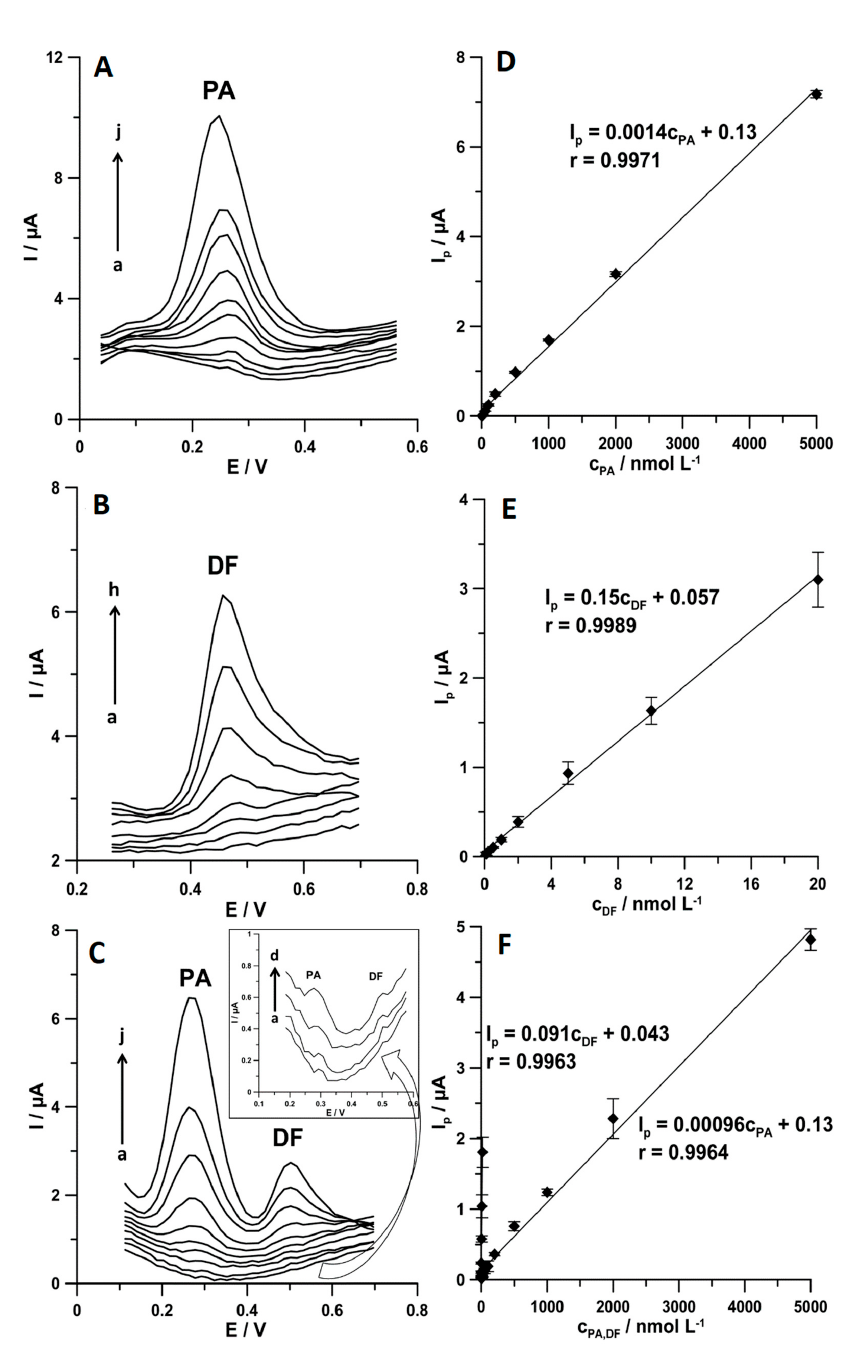
Figure 9. DPAdSV curves registered at the SPCE/MWCNTs-COOH in 0.15 mol L − 1 the acetate buffer solution of pH 4.0 ± 0.1 containing increasing concentrations of the following: ( A ) PA (a–j, 5.0–5000.0 nmol L − 1 ), ( B ) DF (a–h, 0.1–20.0 nmol L − 1 ), and ( C ) PA (a–j, 5.0–5000.0 nmol L − 1 and DF (a–h, 0.1–20.0 nmol L − 1 ). Calibration graph of ( D ) PA, ( E ) DF, and ( F ) PA and DF. The DPAdSV parameters are as follows: E acc. of 0.1 for 1 s and − 0.25 V for 1 s, n cycles = 30 , A of 150 mV, ν of 150 mV s − 1 , and t m of 20 ms.